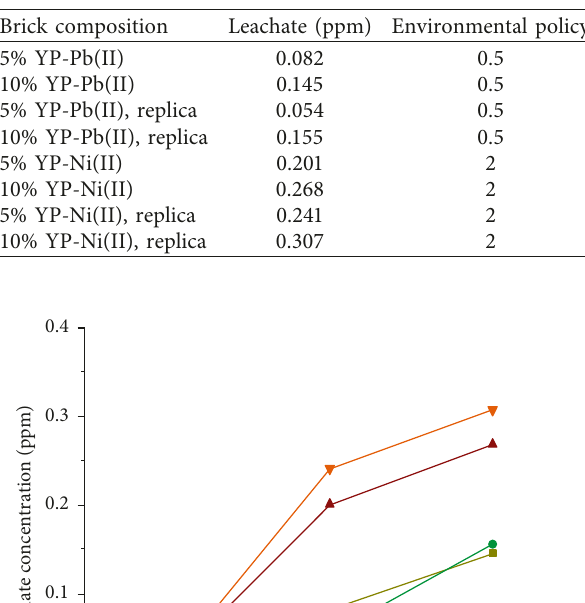
Table 6: Leaching test results.